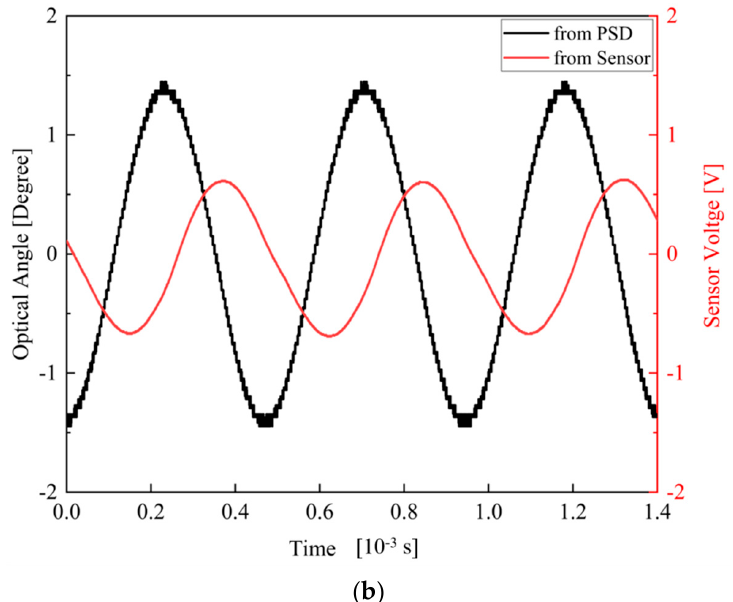
Figure 8. ( a ) Architecture of the closed-loop driving system for the MEMS mirrors. ( b ) Waveform of the angle signal of Mirror I-1 ; PSD signal in black; sensor signal in red.